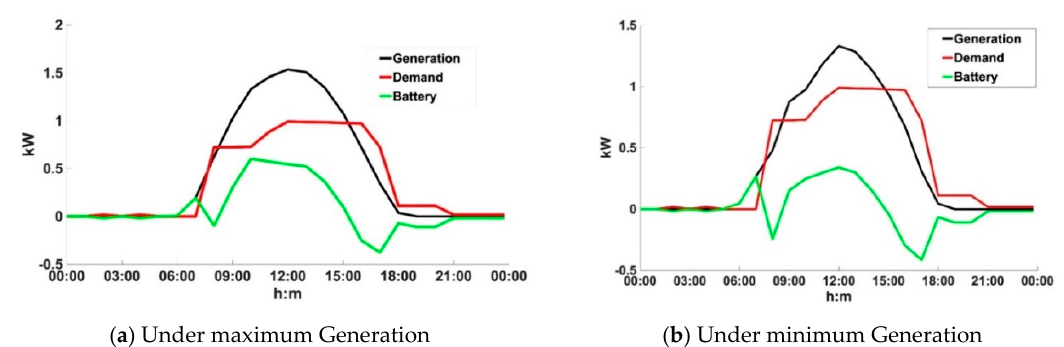
Figure 15. Power flow for generation, demand and battery under high efficiency in the case of maximum and minimum generation: ( a ) under maximum generation; ( b ) under minimum generation.